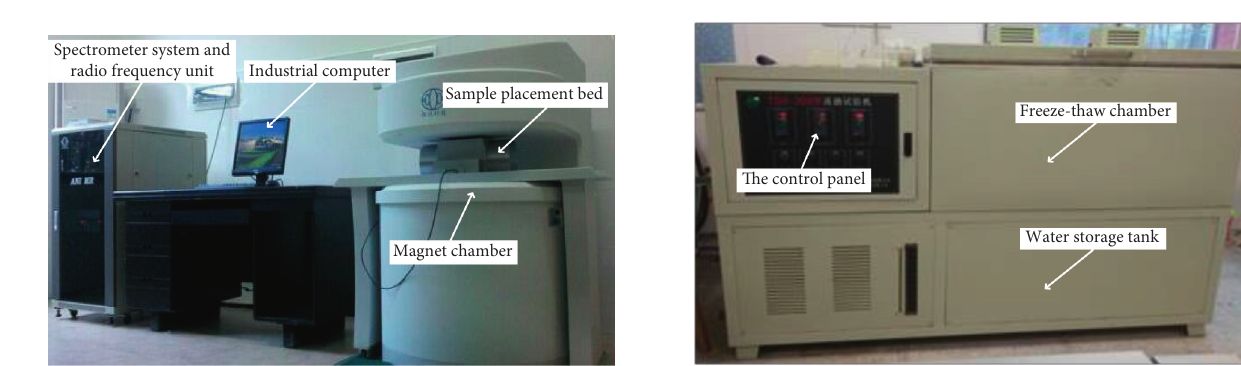
B of various samples under different confining pressure: (a) shale, (b) red sandstone, and (c) granite. i and 2